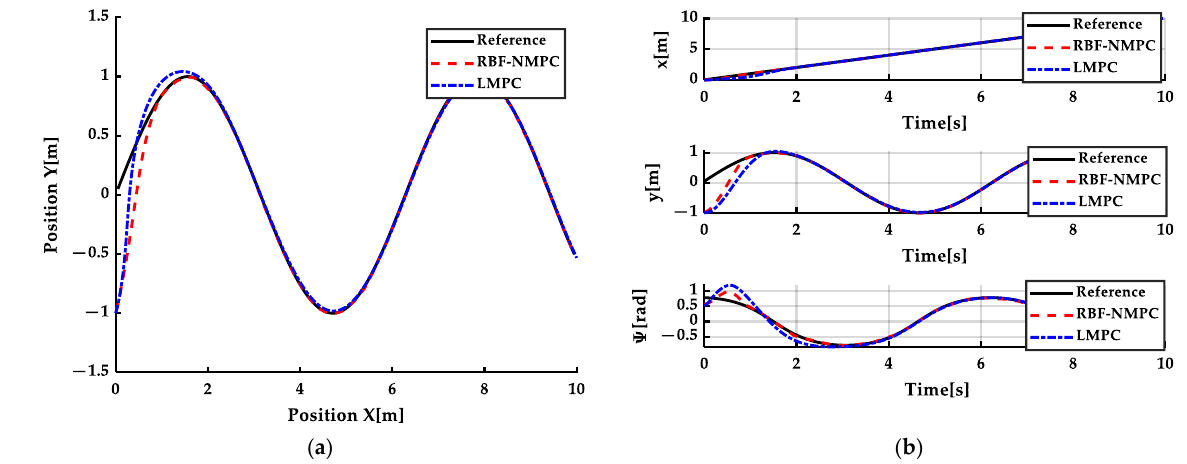
Figure 9. Tracking control comparison results: ( a ) Tracking effect in xoy plane; ( b ) Tracking effect of each state.